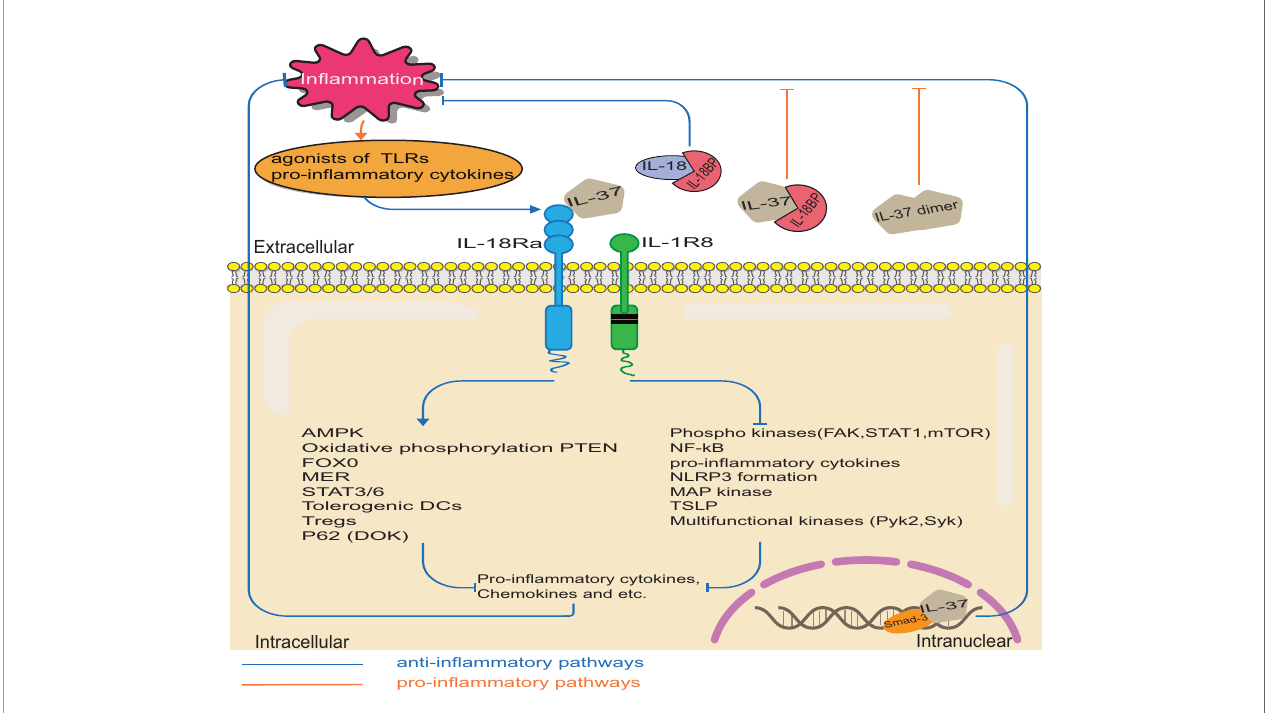
FIGURE 3 | IL-37 signaling pathways. The pro-in fl ammatory stimuli upregulate IL-37 expression, which in turn inhibits in fl ammation through various potential pathways. Intracellularly, IL-37/Smad3 complex reduces the in fl ammatory pathways and increases the production of anti-in fl ammatory cytokine. Extracellular IL-37 binds to IL-18R a /IL-1R8. Therefore, pro-in fl ammatory pathways are inhibited, while anti-in fl ammatory pathways are activated. However, the bind of an excessive amount of IL-18BP with IL-37 reduces the anti-in fl ammatory activity of IL-37 and IL-18BP. Moreover, high concentrations of IL-37 had a weak inhibitory effect on the expression of in fl ammatory cytokines, because of the spontaneous formation of homodimers of